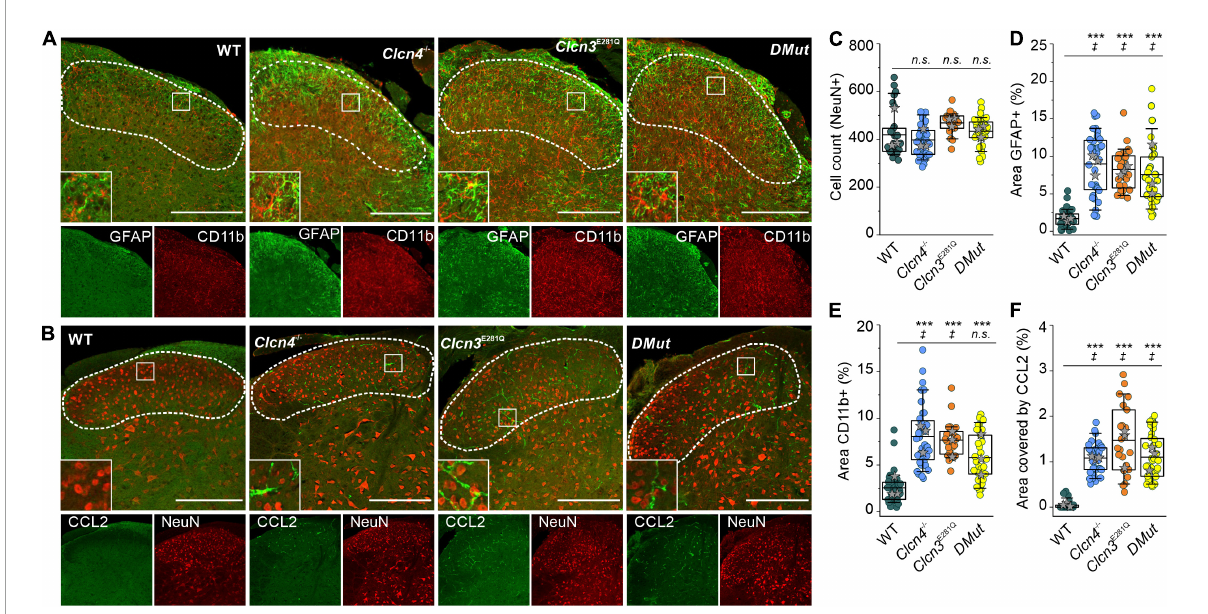
FIGURE6 Reduced Cl - /H + exchange triggers neuroglia activation in the spinal cord. (A) Representative immunofluorescence confocal images of lumbar spinal cord sections from WT, Clcn3 E 281 Q / E 281 Q , Clcn4 − / − , and Clcn3 E 281 Q / E 281 Q /Clcn4 − / − ( DMut ) mice stained for glial fibrillary acidic protein (GFAP) (green) and CD11b (red). Layers I–IV of the dorsal horn are outlined with a dashed line. Insets show increased GFAP and CD11b reactivity in mutant mice. (B) Lumbar spinal cord sections from mice with the indicated genotypes were stained for CCL2 (green) and NeuN (red). (C) Total cell numbers in the dorsal horn of WT and mutant’s spinal cords. (D) Areas of glia positive for GFAP or to CD11b in E for WT ( n = 34), Clcn3 E 281 Q / E 281 Q ( n = 24 ), Clcn4 − / − ( n = 36), and Clcn3 E 281 Q / E 281 Q /Clcn4 − / − ( DMut ; n = 30). (F) Area of CCL2 immunofluorescence in WT ( n = 30), Clcn3 E 281 Q / E 281 Q ( n = 23), Clcn4 − / − ( n = 34), and Clcn3 E 281 Q / E 281 Q /Clcn4 − / − ( n = 36). Each dot represents a single measurement. Three or four mice were used per genotype, with at least six slices from the lumbar section of each animal. Sections were 20- µ m thick and collected every 100 µ m apart. Scale bar: 200 µ m. Asterisk (*) was used to represent differences between groups and ( ‡ ) when also animals were compared ( ‡ p < 0.05, *** p < 0.001). n.s., not significant; one-way ANOVA (Tukey’s HSD post hoc test). In boxplots, boxes indicate the upper and lower quartiles, and whiskers the upper and lower 90